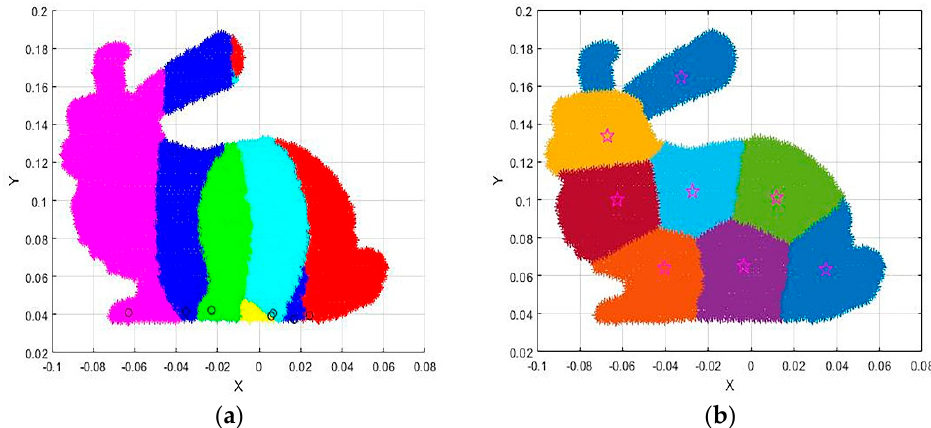
Figure 3. Comparison of FCM and K − means clustering effects under the same number of clusters: ( a ). K − means Algorithm, the circles represent the clustering centers of K − means; ( b ). FCM Algo- rithm, the stars represent the clustering centers of FCM.